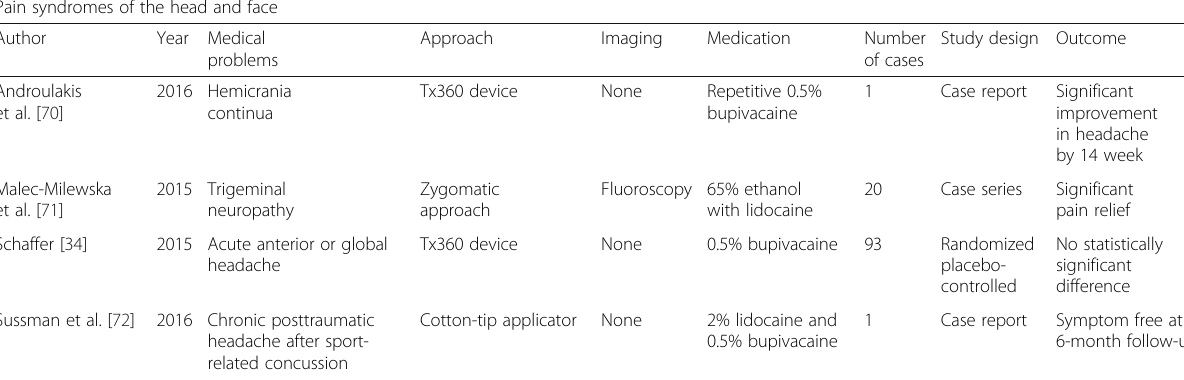
Table 11 Studies of SPG blocks for other pain syndromes of the head and face (Continued) Pain syndromes of the head and